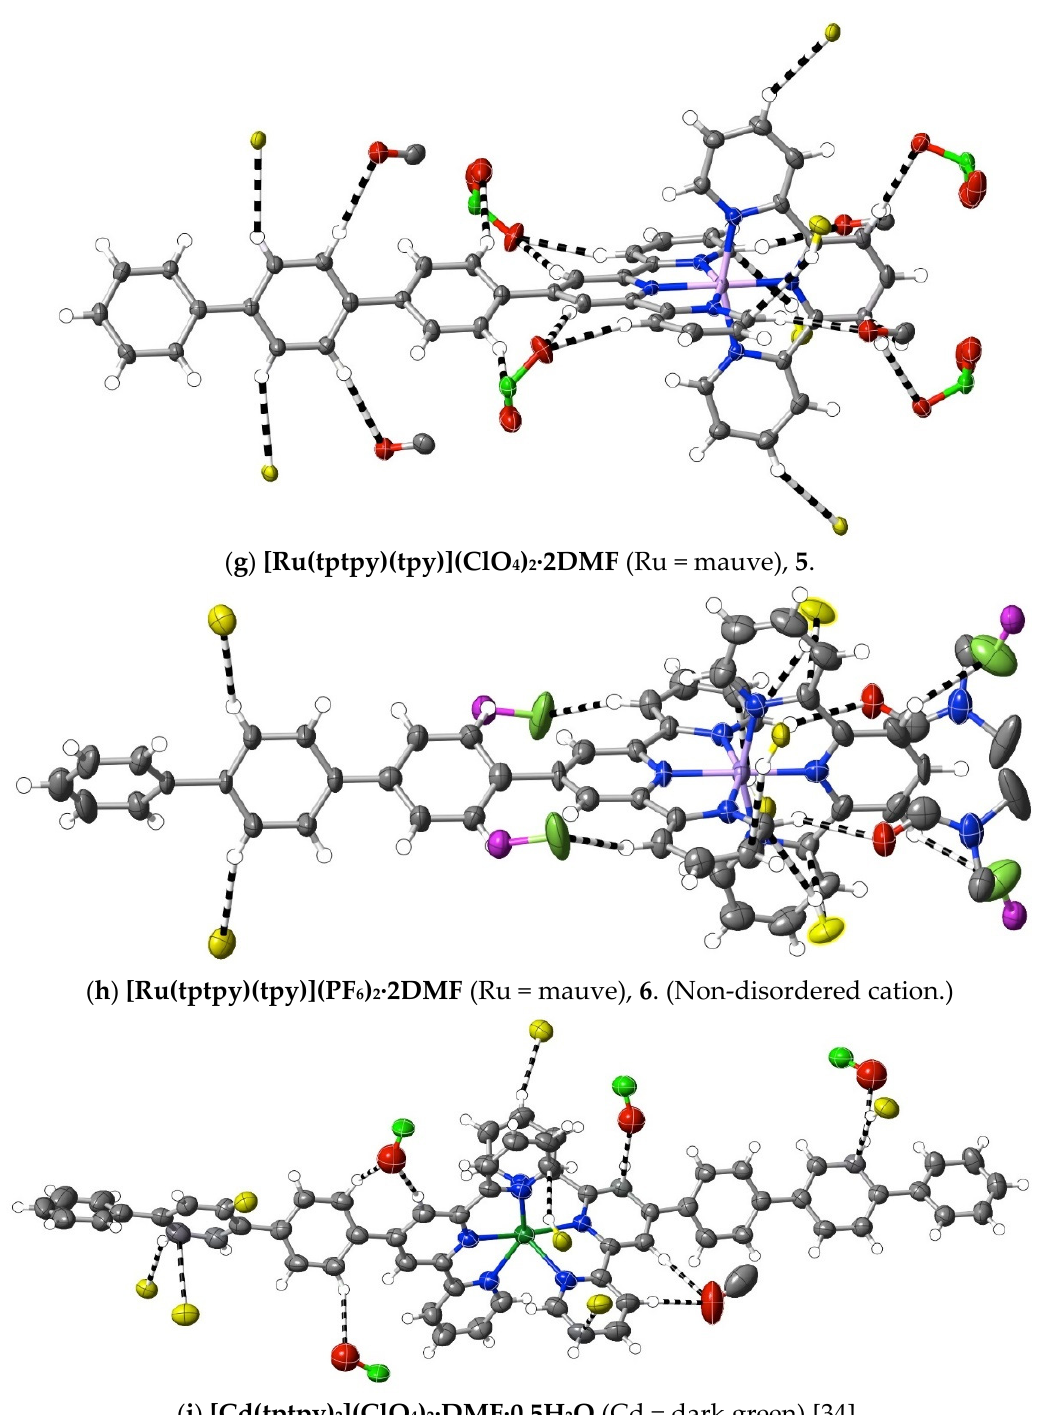
Figure 4. Interactions exceeding dispersion (dashed lines) of cations complexed by 4 ′ -terphenyl-2,2 ′ :6 ′ ,2 ″ -terpyridine. As in Figure 1, C-atoms of ligands not directly bound to the one metal ion involved are shown in yellow. Different O-atoms involved are identified by their attached atoms (e.g., Cl for perchlorate-O).